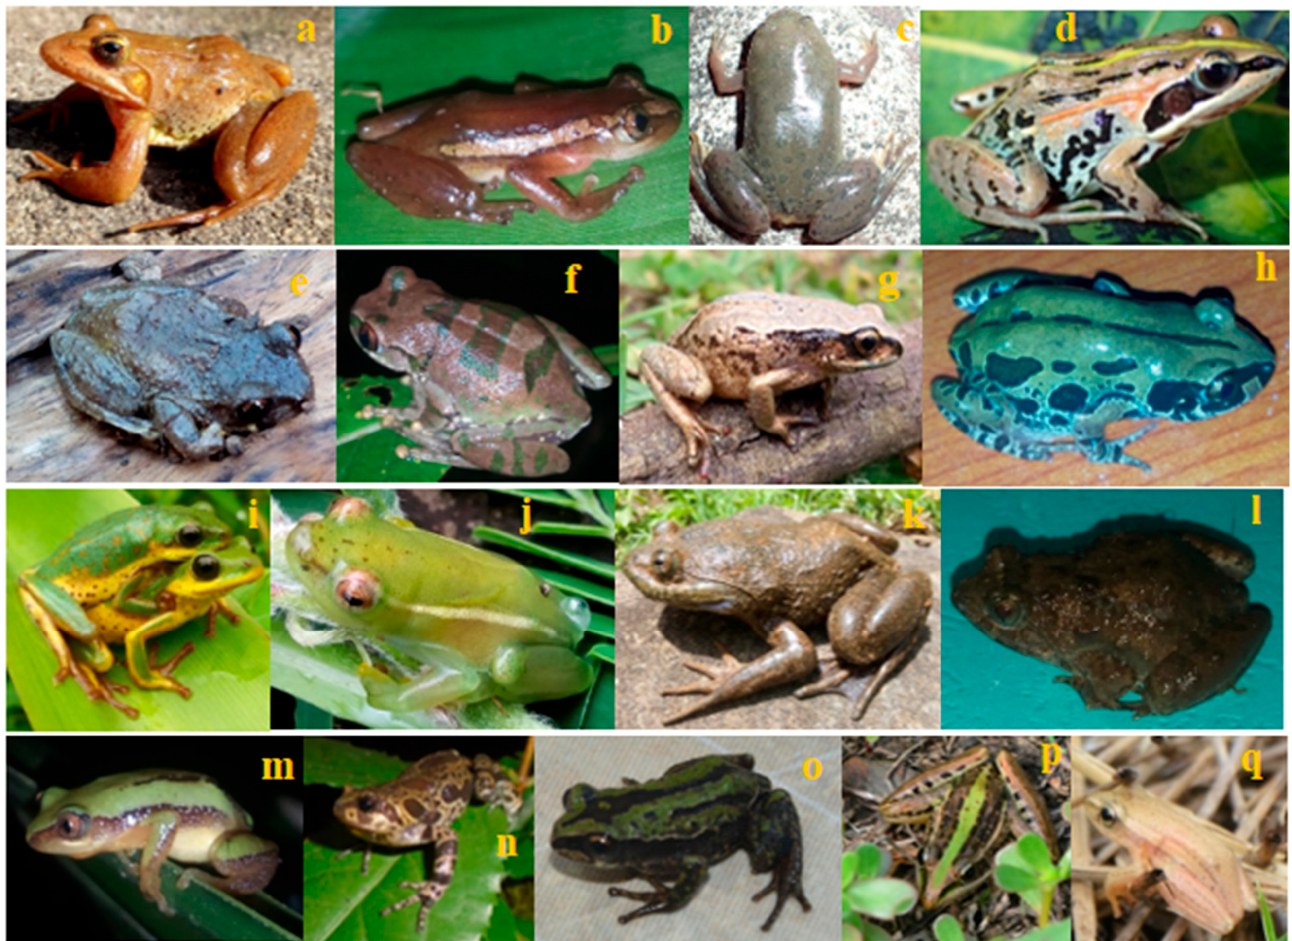
Figure 5. Some of the frog pictures recorded from the Keffa area. ( a ) Amietia nutti ; ( b ) Afrixalus enseticola ; ( c ) Xenopus clivii ; ( d ) Ptychadena erlangeri ; ( e ) Leptopelis sp. 2; ( f ) Leptopelis vannutellii ; ( g ) Leptopelis sp. 1; ( h ) Kassina senegalensis ; ( i ) Hyperolius viridiflavus ; ( j ) Hyperolius microps ; ( k ) Conraua beccarii ; ( l ) Phrynobatrachus natalensis ; ( m ) Afrixalus clarkei ; ( n ) Paracassina obscura ; ( o ) Leptopelis cf. susanae ; ( p ) Ptychadena nilotica ; ( q ) Hyperolius kivuensis. Table 3. Species and genus composition, abundance and relative abundance among families in Keffa.